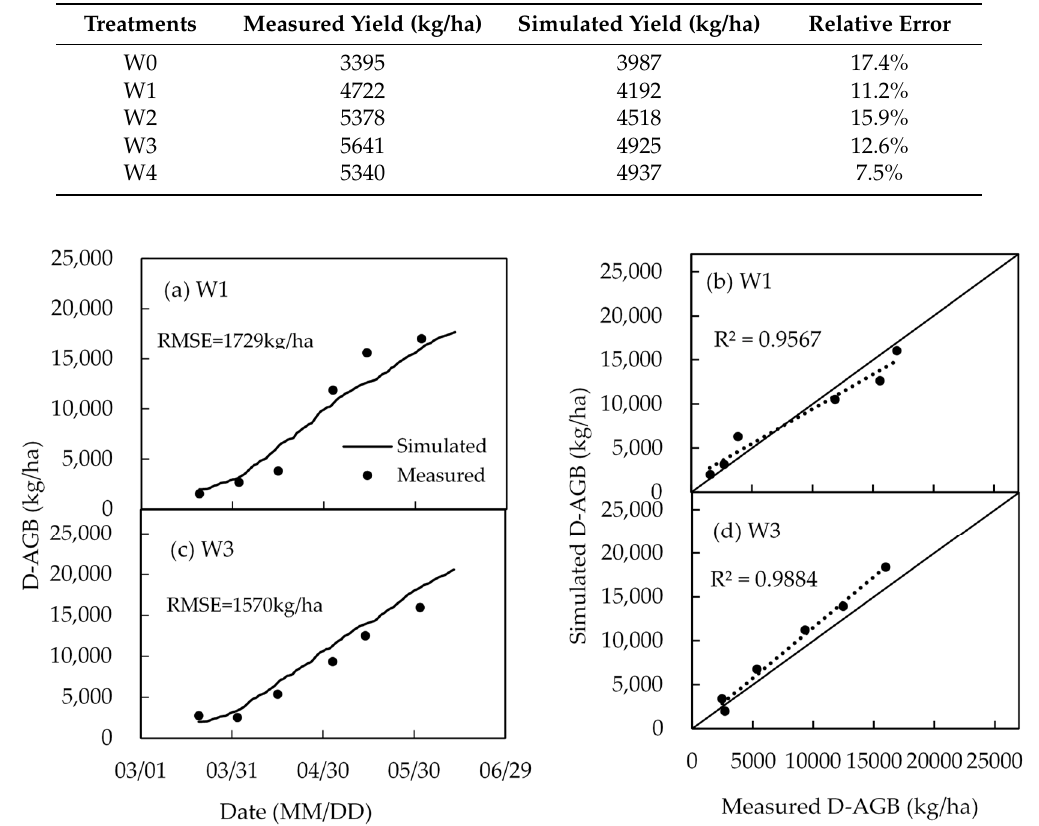
Figure 15. Comparison of measured and simulated above-ground dry biomass in validation